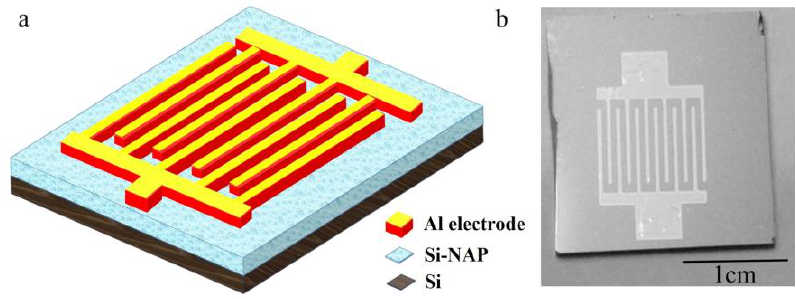
Figure 1. ( a ) The schematic diagram of the designed sensors. ( b ) A photo of the actual